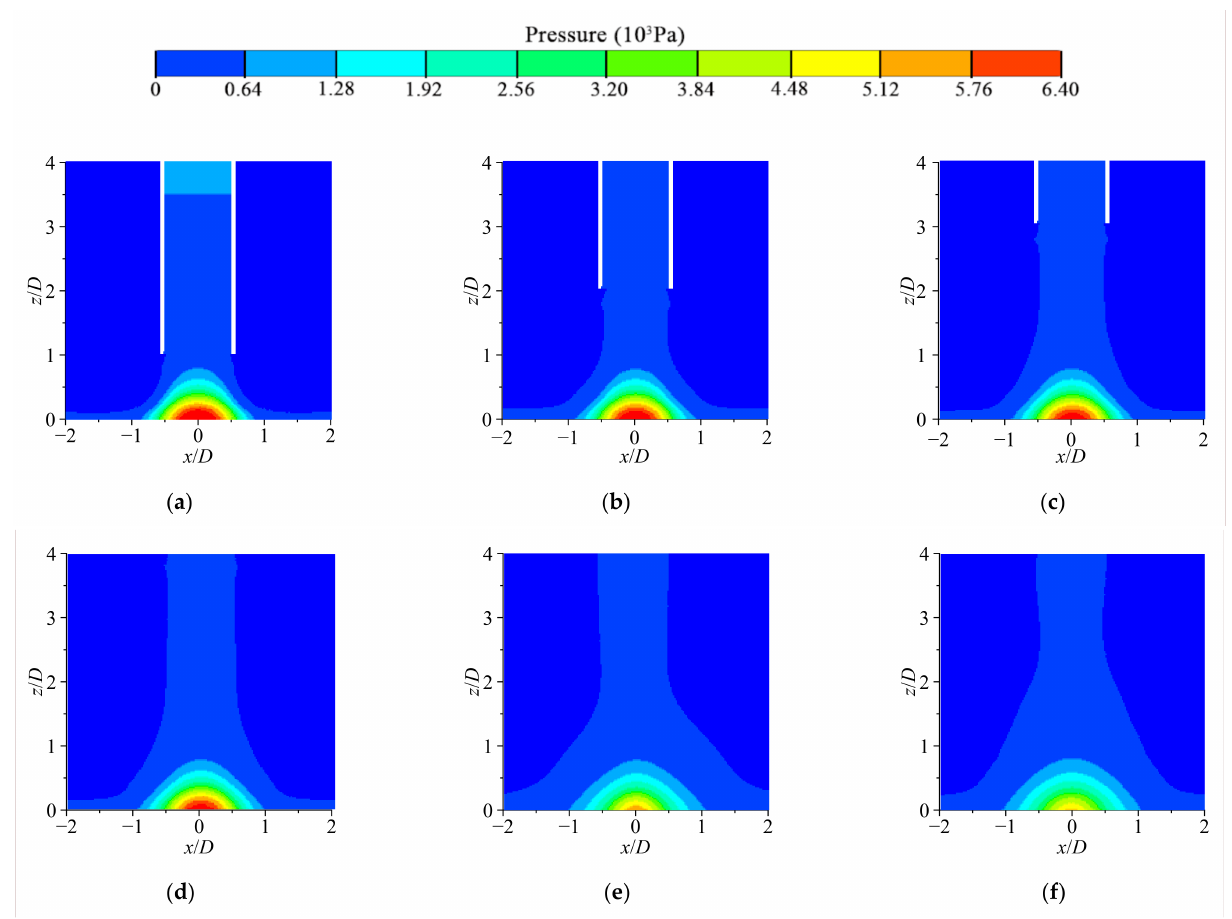
Figure 15. Nephogram of cross-sectional pressure distribution in impinging jets at different impact heights: ( a ) H/D = 1; ( b ) H/D = 2; ( c ) H/D = 3; ( d ) H/D = 4; ( e ) H/D = 6; ( f ) H/D = 8.